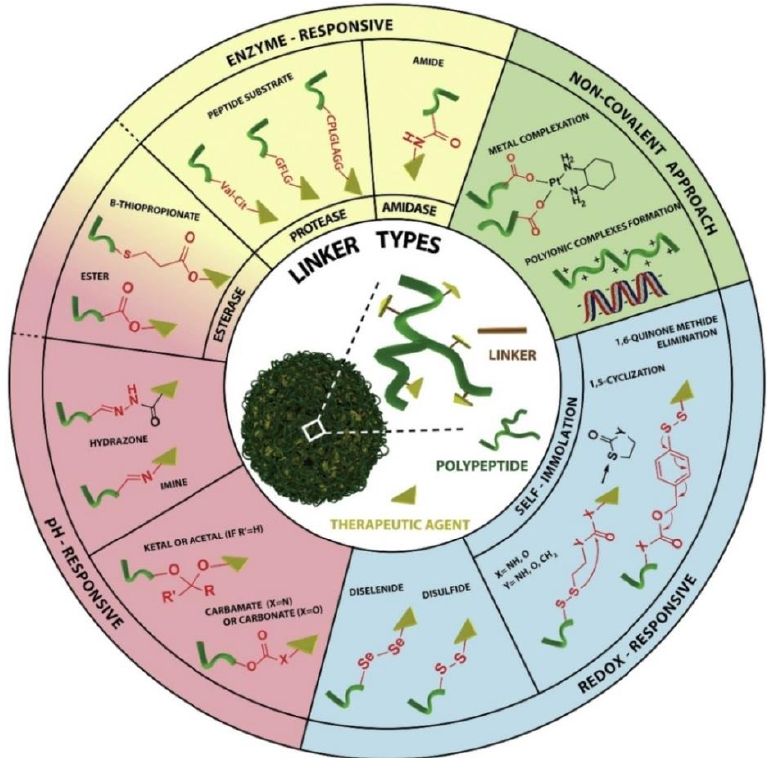
Figure 2. Different types of polypeptide-drug linkers commonly used in the rational design of polypeptide-drug conjugates (Adopted under CC BY 4.0 from [103]). In the figure, white bubble indicates PDCs. The green triangle is a therapeutic agent. The red colored line indicates the linker and the green colored ribbon type structure indicates polypeptide. In the linker, different types of linkers are discussed.